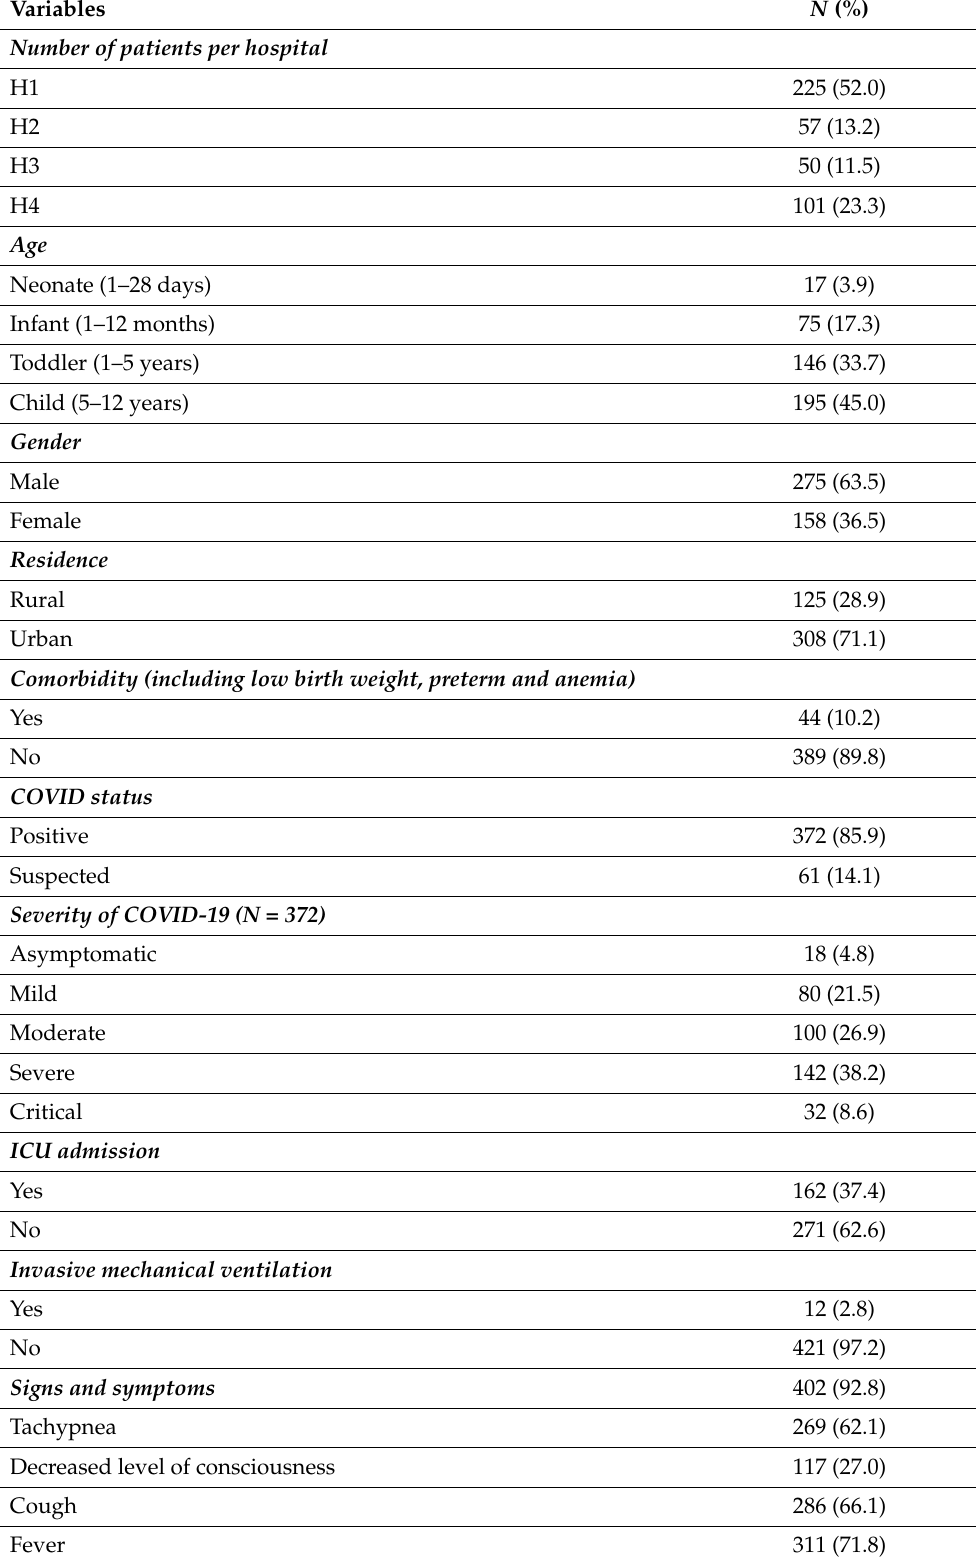
Table 1. Demographic and clinical characteristics of the